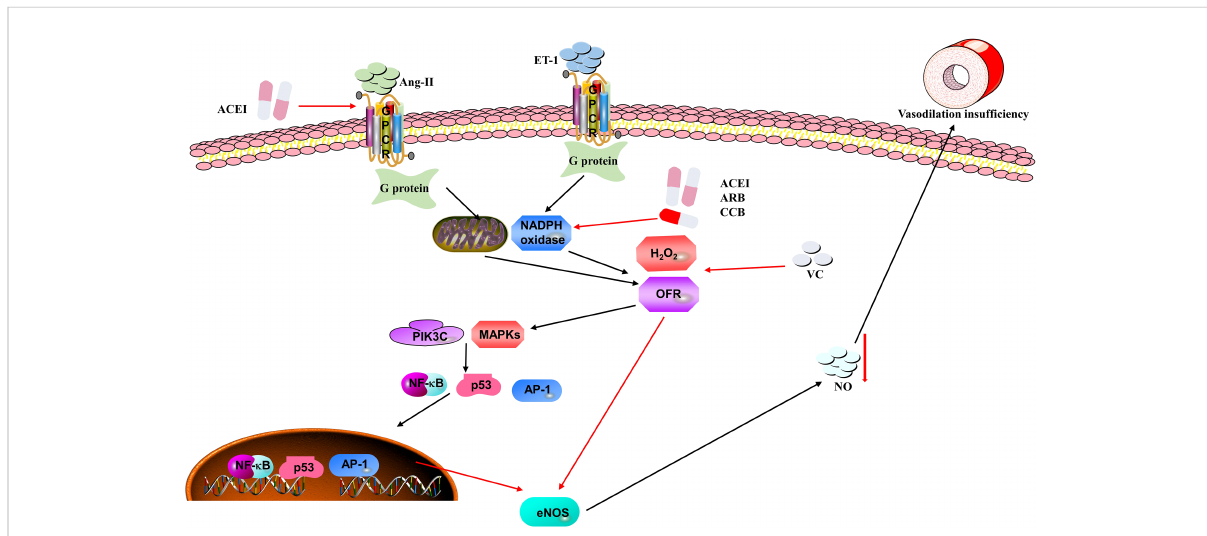
FIGURE 3 Mechanisms of oxidative stress causing hypertension in vascular endothelial cells. Ang II and ET-1 can stimulate NADPH oxidase and mitochondria to produce ROS (e.g., H2O2 and OFR), which are recognized by their receptors on the endothelial cells. ROS stimulate the PI3K/ Akt-MAPK pathway to inhibit the expression of eNOS mRNA and eNOS activity, thus reducing the availability of NO, which results in vasodilation insuf fi ciency and elevation of blood pressure. Moreover, angiotensin converting enzyme inhibitors (ACEIs), angiotensin receptor blockers (ARBs), calcium channel blockers (CCBs) and vitamin C (VC) may be potential therapeutic strategies in the process of oxidative